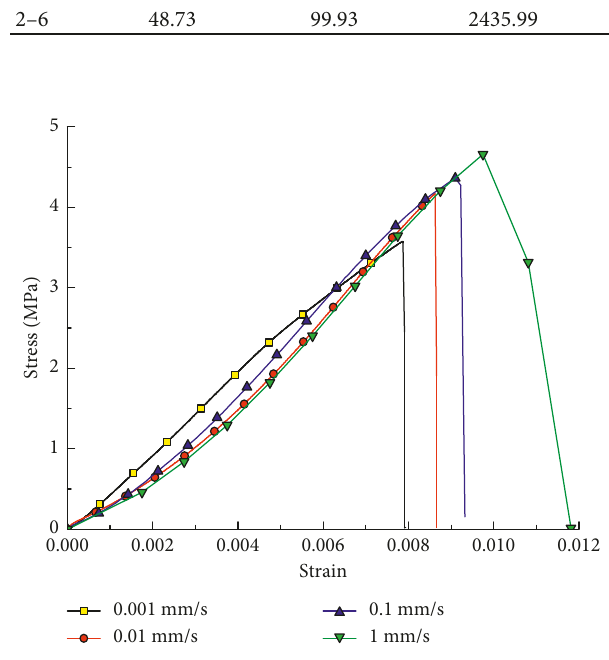
Figure 6: Stress-strain curves of the specimens under different loading rates.